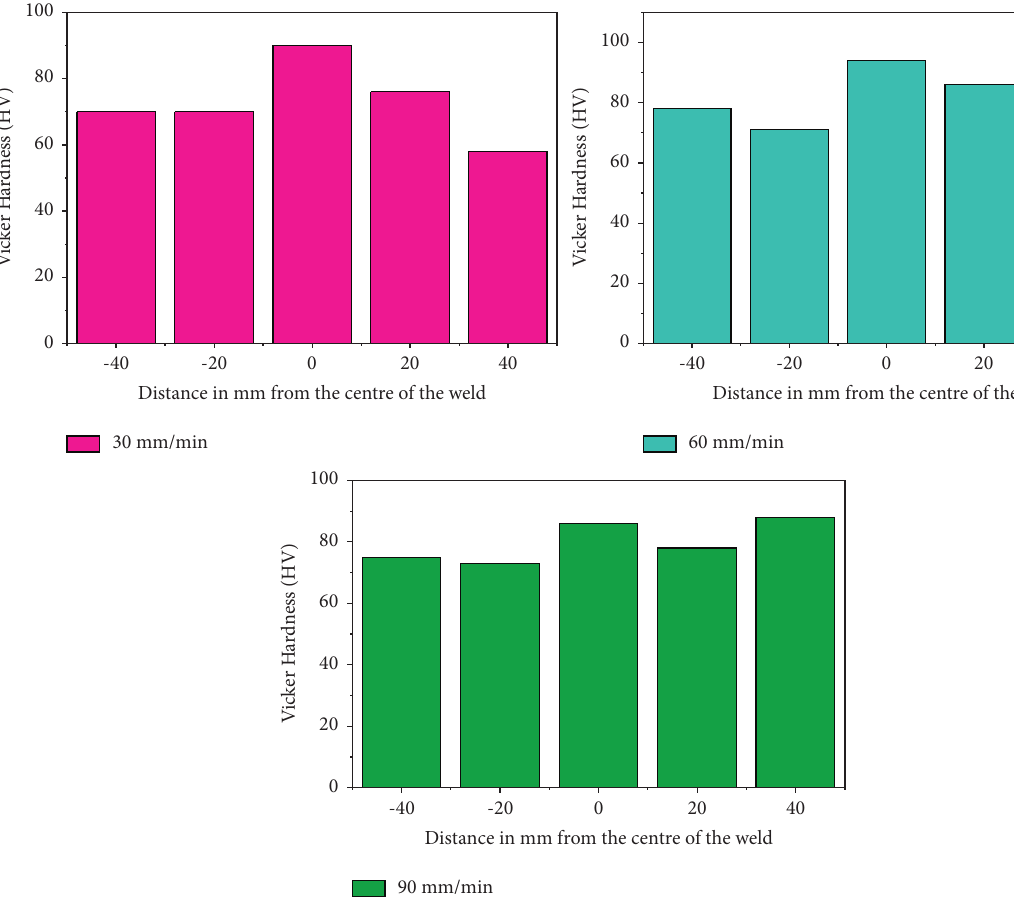
Figure 8: Vickers hardness value for the taper